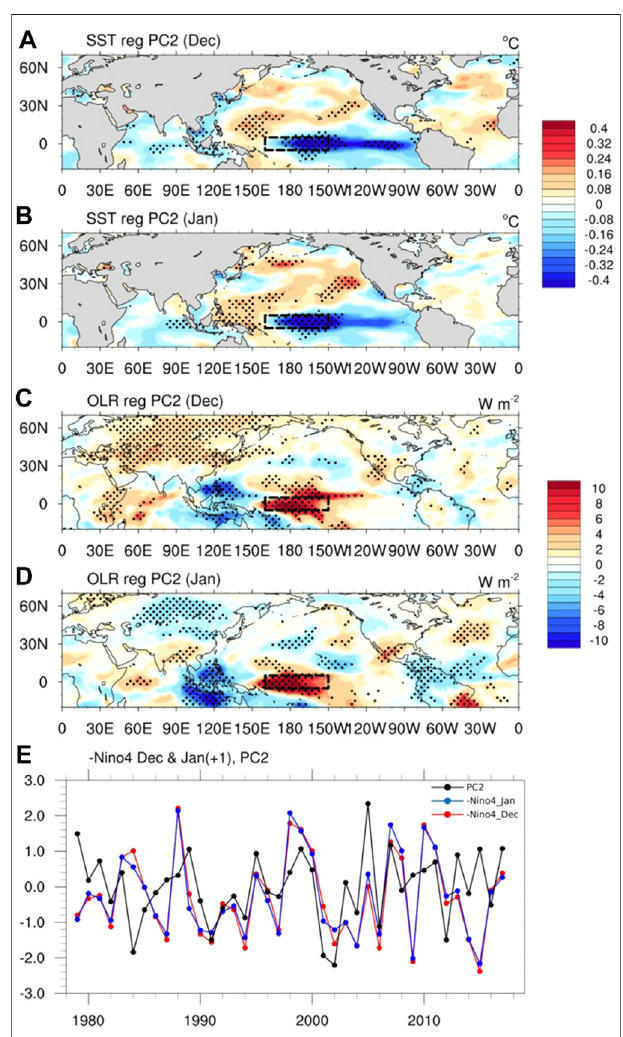
FIGURE 4 | Regressions of (A) SST (shading; ° C) and (C) OLR (shading; W m − 2 ) onto the PC2 for the period 1979 – 2017 (B,D) As in (A,C) but for January during 1980 – 2018 (E) Time series of the standardized − Niño4 index in December (red line), January (blue line) and PC2 (black line) during 1979 – 2018.Anomaliessigni fi cantatthe95%con fi dencelevelaredenotedby dots,asestimatedbytheStudent ’ s t- test.Theblackdashedboxesin(A,B,C, D) show the Niño4 region (5 ° S ‒ 5 ° N, 160 ° ‒ 150 ° W).